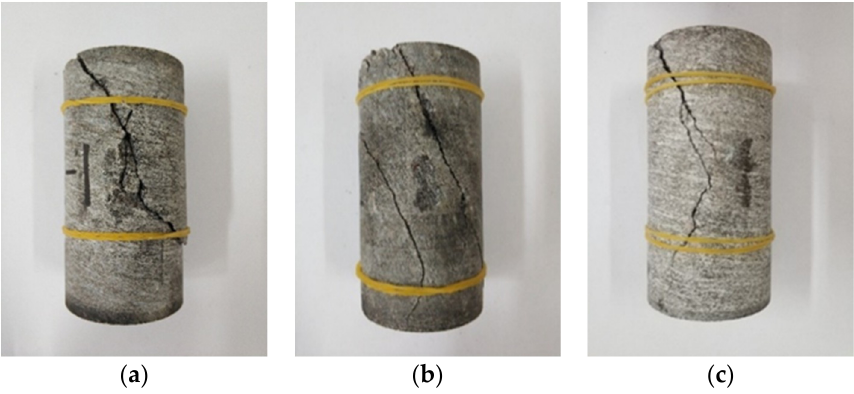
Figure 7. Failure mode of gneiss in the conventional geostress area. ( a ) C-1. ( b ) C-2. ( c ) C-3.